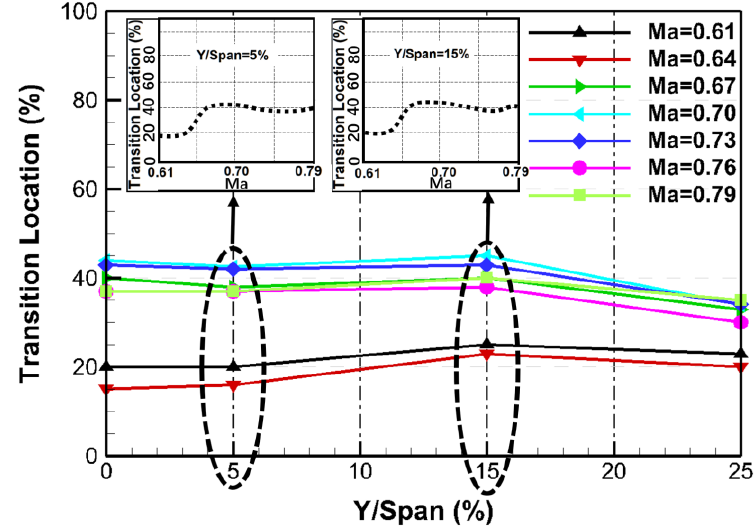
Figure 18. Comparison of the transition location of the central experiment wing with different Ma .